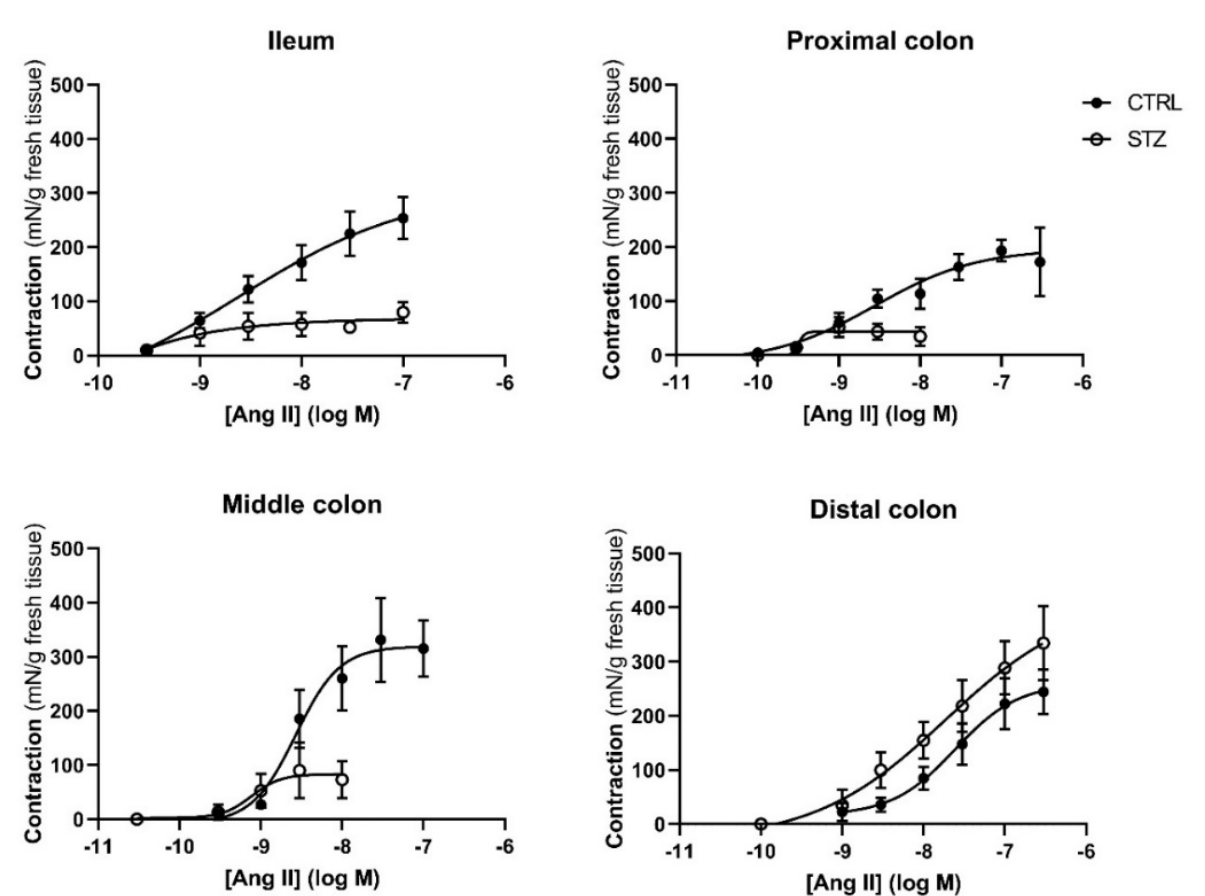
Figure 7. Concentration-response curves to Angiotensin II in the ileum, proximal colon, middle colon and distal colon of control (CTRL, n = 5–8) and streptozotocin-induced diabetic rats (STZ, n = 5). Data are expressed as mN of force per g of fresh tissue (mN/g). Values are mean ± SEM. Table 1. E max (mN/g) and EC 50 ( µ M) values of smooth muscle contraction induced by ACh appli- cation in the ileum, proximal colon, middle colon and distal colon of control (CTRL, n = 6–7) and Table 2. E max (mN/g) and EC 50 (µM) values of smooth muscle contraction induced by Angiotensin II application in the ileum, proximal colon, middle colon, and distal colon of control (CTRL, n = 5–8) and streptozotocin-induced diabetic rats (STZ, n = 5).